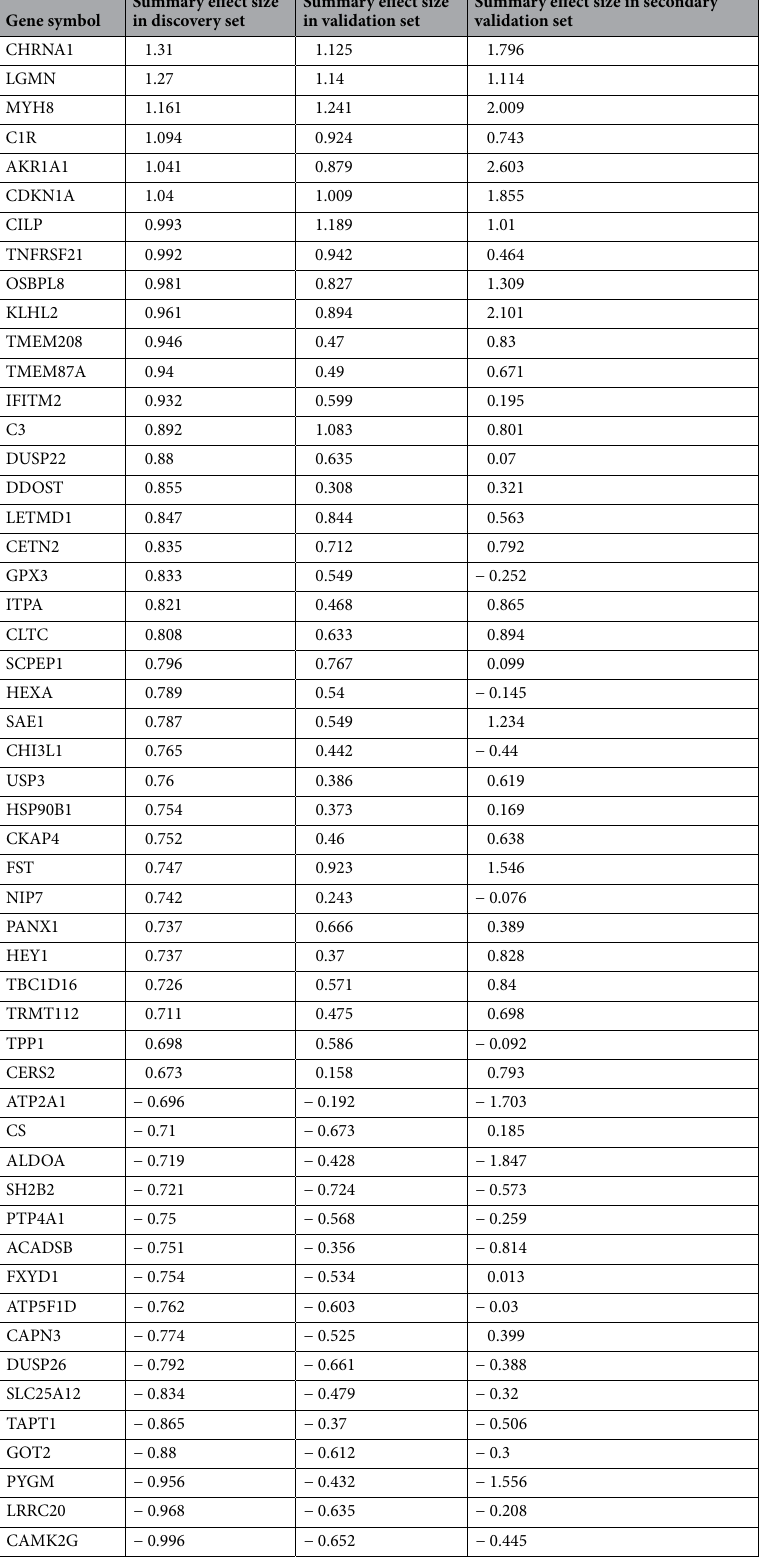
Table 2. Common muscle disease module (CMDM) genes. Genes are listed from the largest absolute meta- effect size to the smallest (from summary effect size in discovery